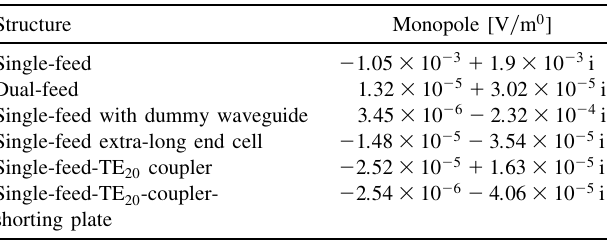
TABLE III. Minimum achieved monopole component for CLIC crab cavity structures discussed. All values correspond ¼ 1 V to lossy walls and V crab